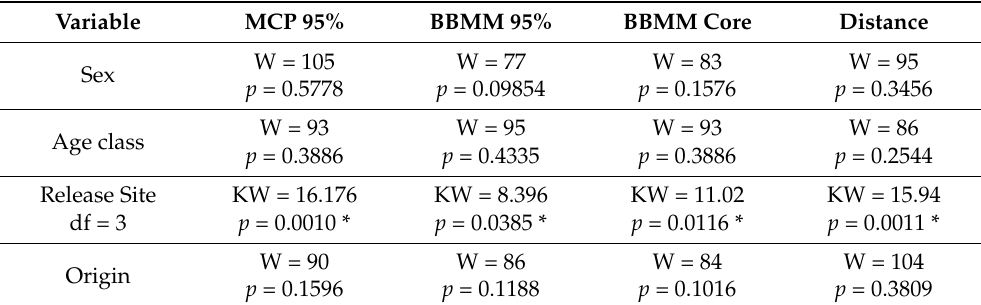
Table 3. Differences in home range size and distance from the release